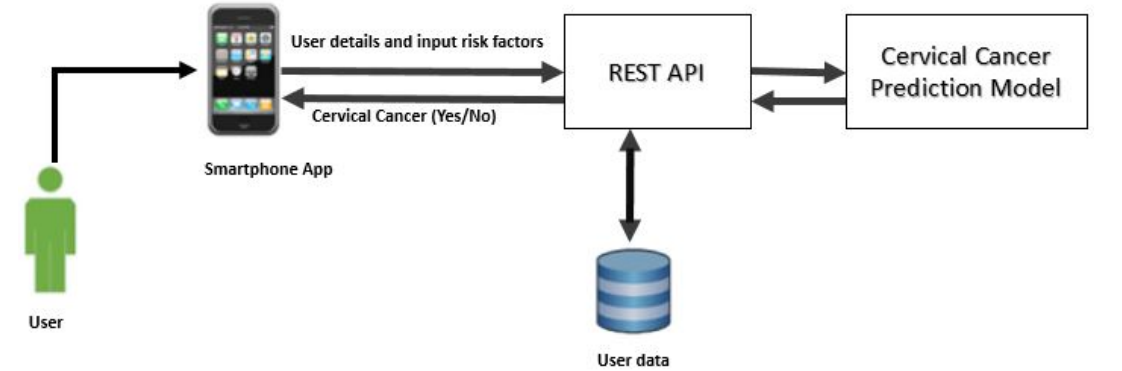
Figure 3. Cervical Cancer Predication Model architecture framework.